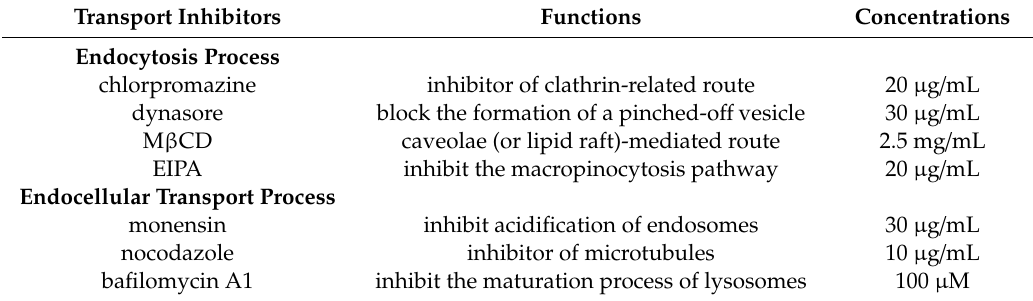
Table 2. Functions and concentrations of transport inhibitors. M β CD, methyl- β -cyclodextrin. Transport Inhibitors